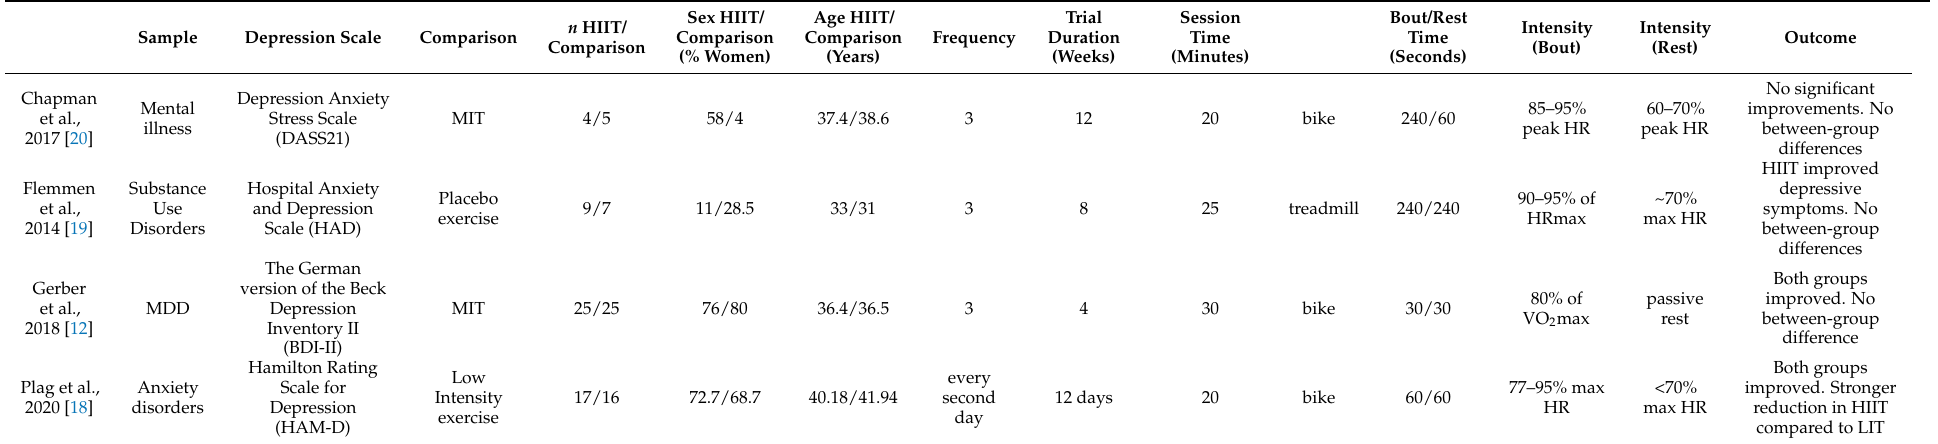
Table 1. Studies’ characteristics and